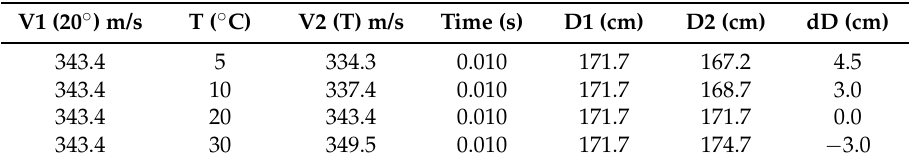
Table 3. Comparison table between the distance measured at the standard temperature of 20 ˝ C (columns V1 and D1), and the distance measured at the actual temperature (columns V2 (t) and D2). V1 (20 ˝ ) m/s T ( ˝ C) V2 (T) m/s Time (s) D1 (cm) D2 (cm) dD (cm) 343.4 5 334.3 0.010 171.7